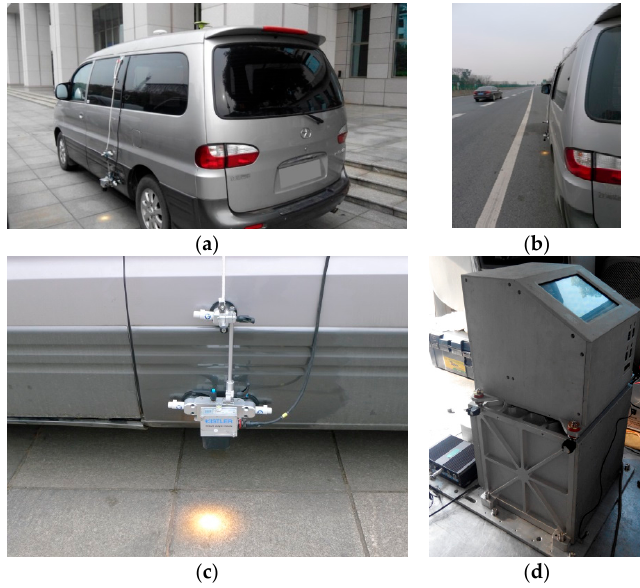
Figure 1. ( a ) Test car equipped with SGA-WZ02 (in the cabin) and KISTLER Correvit ® S-350 velometer; ( b ) Test car is driving on the highway; ( c ) The working velometer installed along the side door of